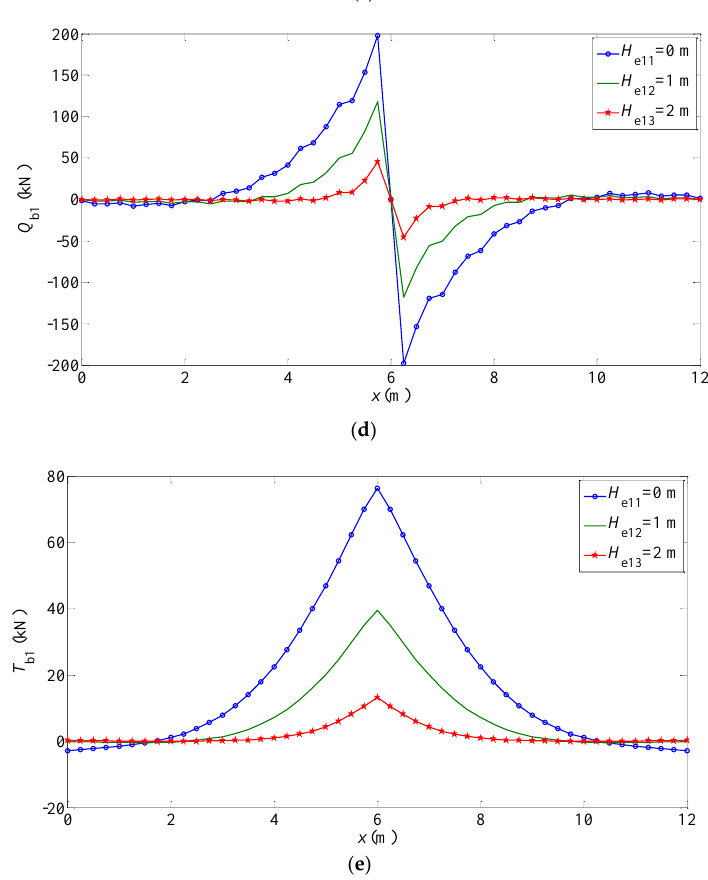
Figure 5. Mechanical behavior of a beam embedded in a Gibson elastic foundation ( η 1 = 0.5). ( a ) Displacement of a beam embedded in a Gibson elastic foundation ( η 1 = 0.5); ( b ) rotation angle of a beam embedded in a Gibson elastic foundation ( η 1 = 0.5); ( c ) bending moment of a beam embedded in a Gibson elastic foundation ( η 1 = 0.5); ( d ) shear force of a beam embedded in a Gibson elastic foundation ( η 1 = 0.5); ( e ) subgrade force of a Gibson elastic foundation ( η 1 = 0.5). Table 2. Results for a beam embedded in a Gibson elastic foundation ( 1